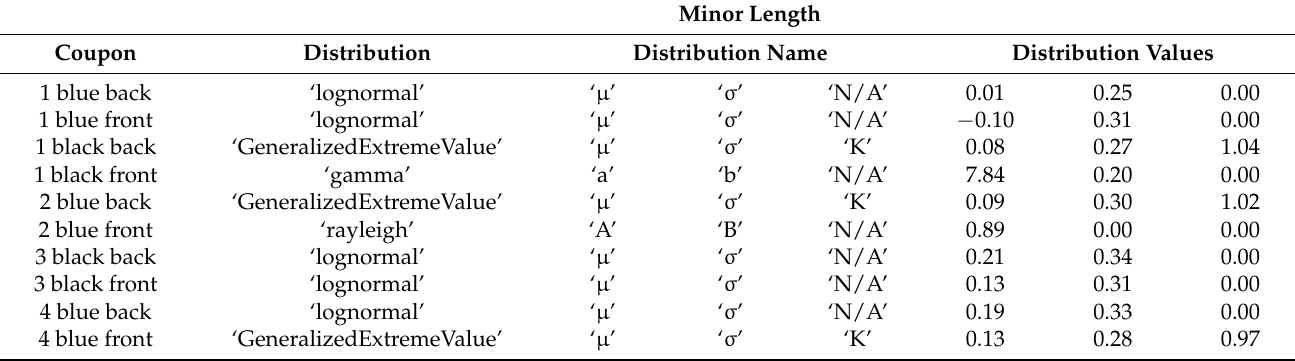
Table 5. Minor length statistical